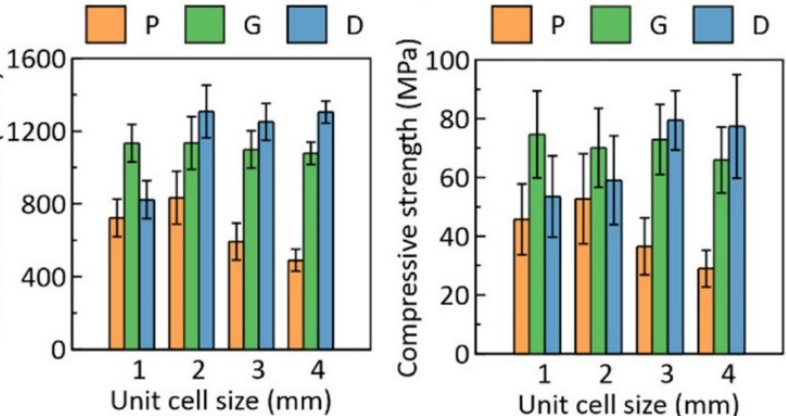
Figure 7. Characterization of the cubic porous scaffolds under compressive loading. Elastic modulus and compressive strength resulted from the stress-strain curves for samples with 0.75 porosity. Reprinted with permission from ref. [99]. 2021, American Chemical Society.